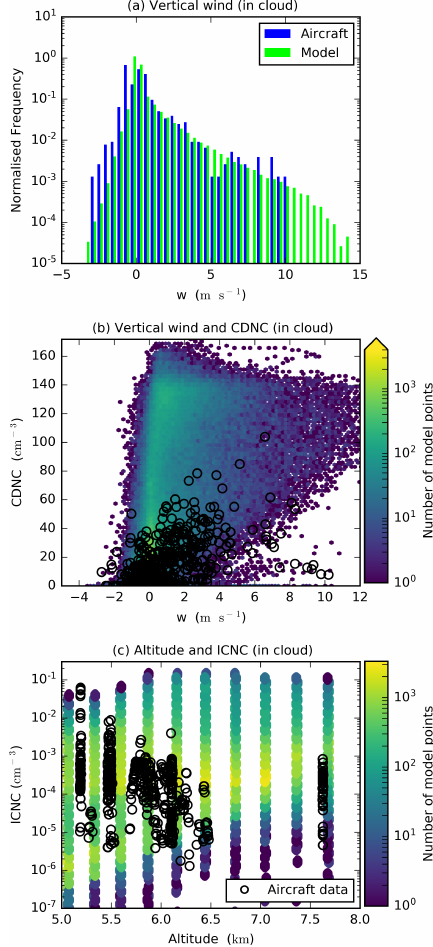
Figure A2. Comparison of observed conditions from the B933 ICED field campaign flight on 21 August 2015 and the modelled conditions. Vertical wind speed from the model and aircraft data (a) , a 2D histogram of modelled vertical wind against cloud droplet number concen- tration (CDNC) (b) and altitude plotted against ice crystal number concentration (ICNC) (c) with the aircraft data overlaid. Modelled values are selected from clouds between 10 and 150km 2 in size from the N12